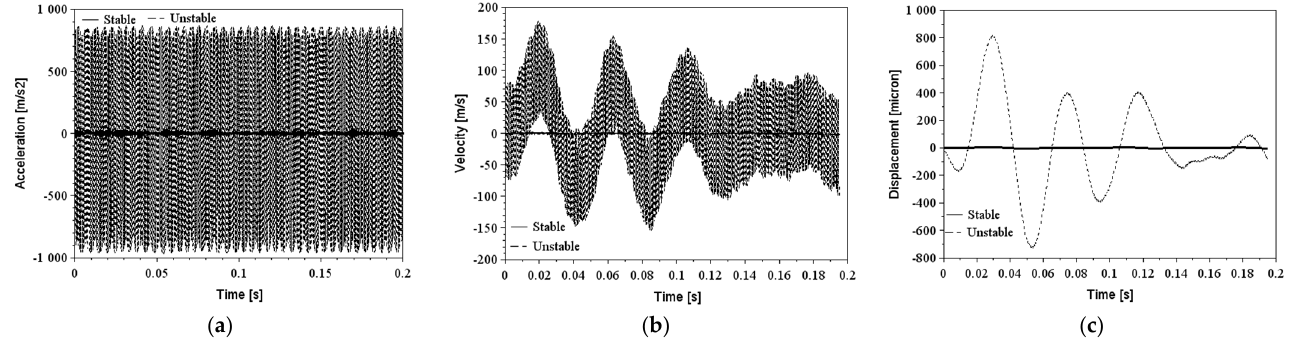
Figure 13. Excitation signals in stable TSC = 21.43 mm − 1 conditions with a carbide boring bar: ( a ) acceleration; ( b ) velocity; ( c ) displacement amplitudes.